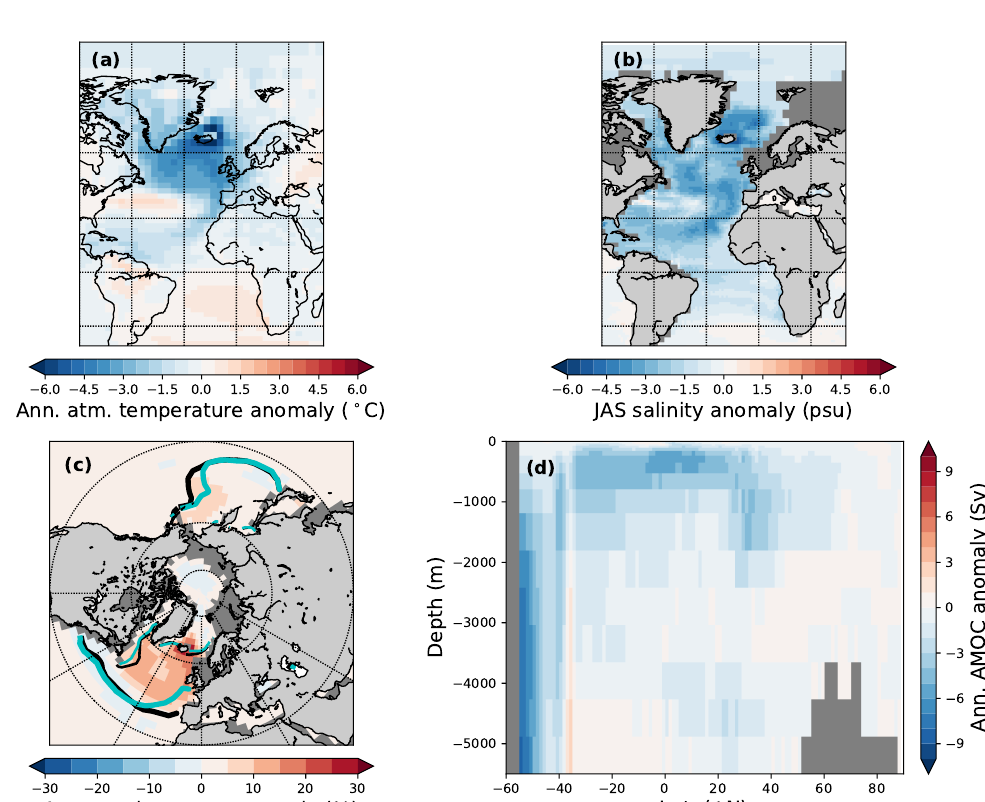
Figure 10. Composite of stadial–interstadial conditions (38.72–39.5kyr vs. 37.54–38.32kyr) for the surrogate time series constructed using the analogs picked with SSTs from the HadCM3 pool for panels (a–c) and HadCM3 (cid:63) for panel (d) . Colors show (a) annual atmospheric temperature anomalies, (b) JAS ocean salinity anomalies, (c) annual sea-ice cover concentration anomalies, and (d) annual AMOC anomalies. The black and blue contour lines in panel (c) are the 0.15 sea-ice concentration lines for stadial and interstadial, respectively, thick for March and thin for